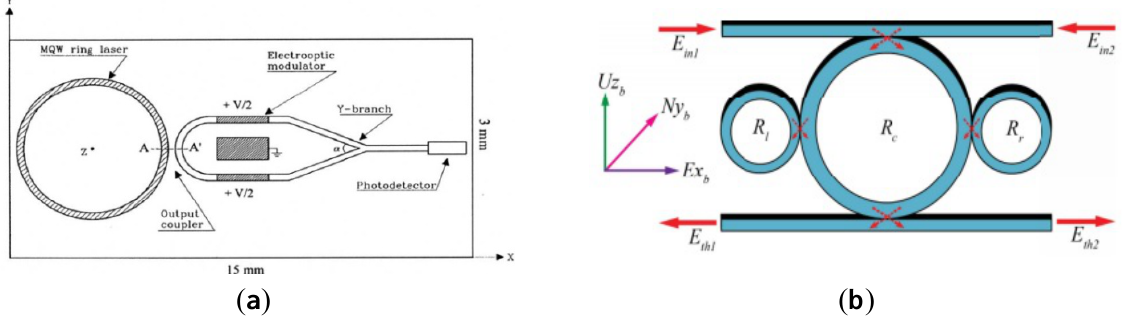
Figure 18. ( a ) Multiple quantum MFOG. ( b ) PANDA ring